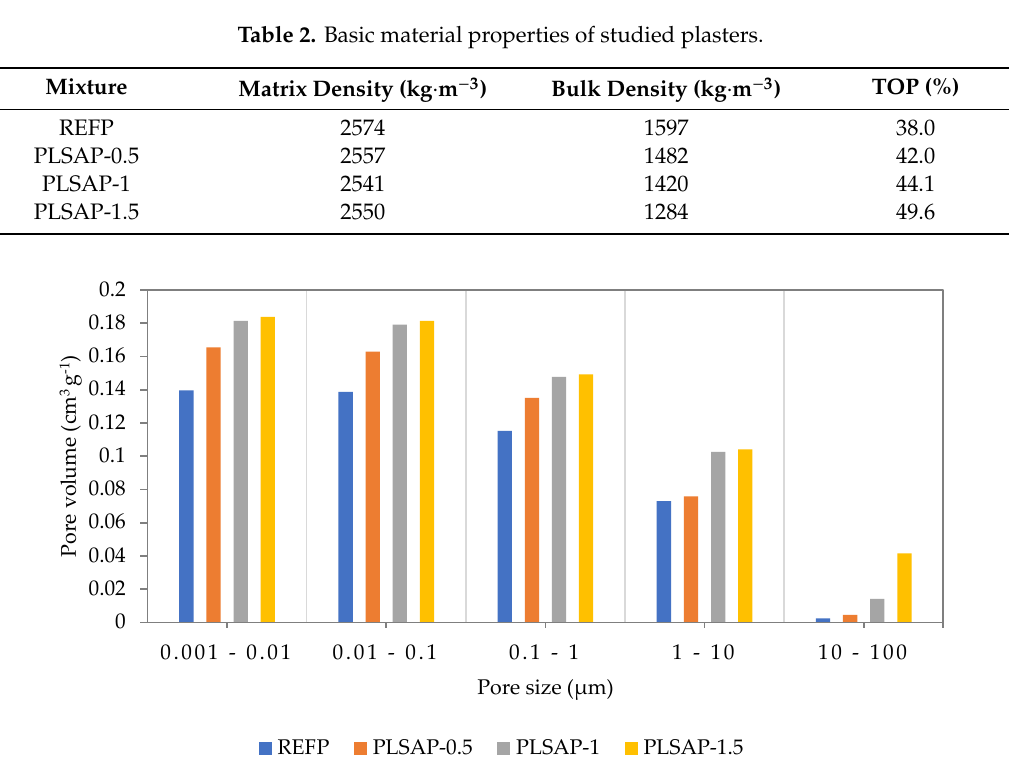
Figure 2. Pore size distribution of studied plasters.